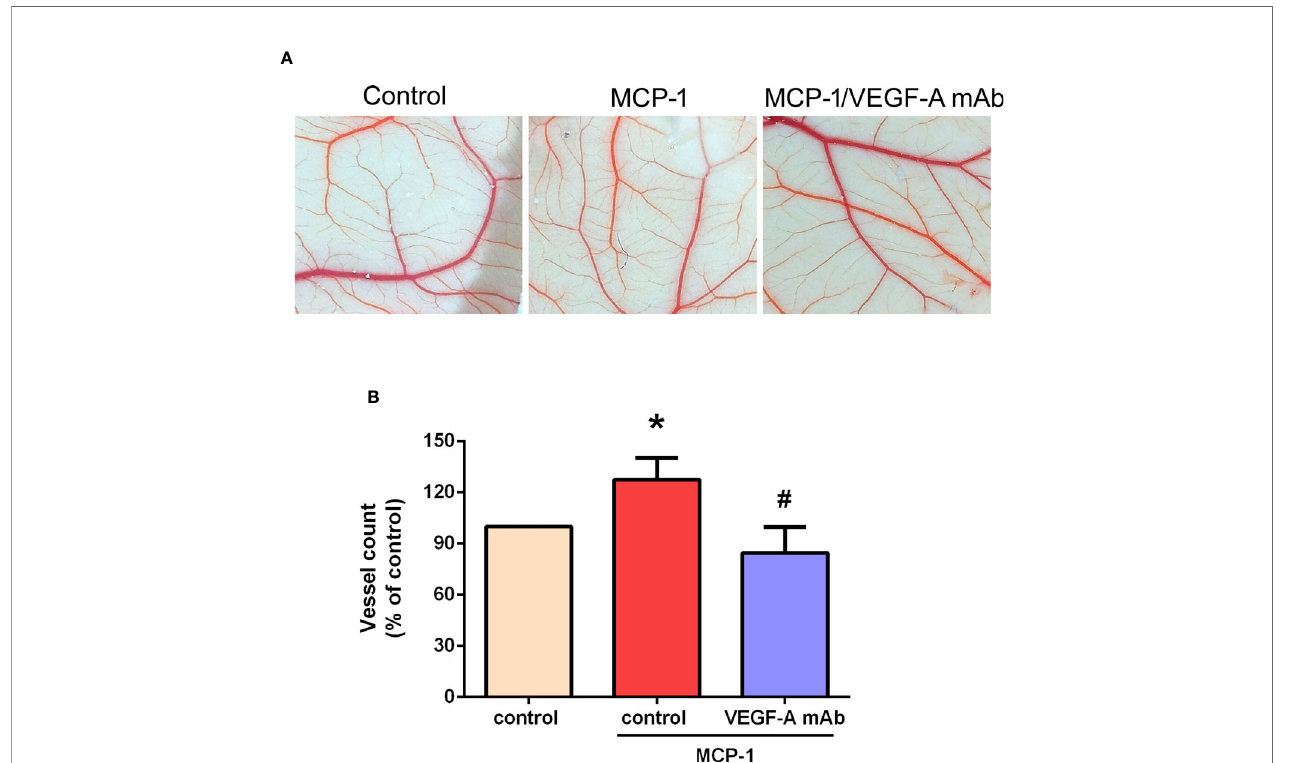
FIGURE 6 | Effects of MCP-1 on VEGF-A-induced angiogenesis in the CAM model. (A) Cells were incubated with or without MCP-1 (50 ng/ml) for 24 h, or treated for 30 min with VEGF-A antibody (5 m g/ml) followed by MCP-1 (50 ng/ml) for 24 h. CM was collected and suspended in Matrigel, then incubated with chick embryos (n=5 in each group) for another 72 h. Chorioallantoic membranes were collected for microscopy and photographic documentation. (B) Angiogenesis was quanti fi ed by manually counting the number of blood vessel branches. * p < 0.05 compared with controls; # p < 0.05 compared with MCP-1 – treated controls. Each experimental procedure was independently repeated three times, with similar results.